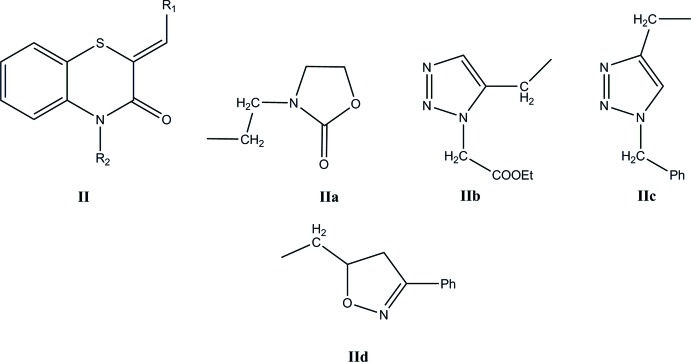
Related structures.